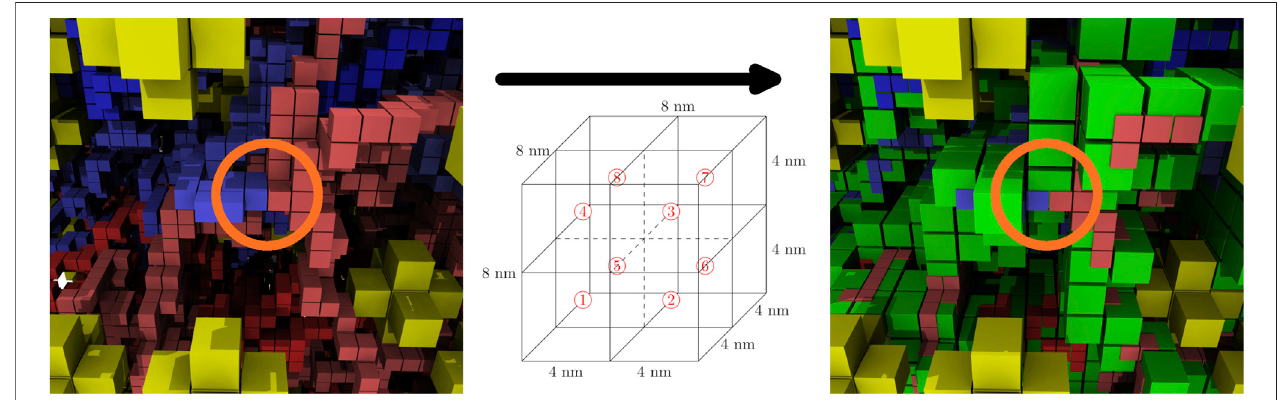
FIGURE 8 | Coarse-graining, before and after — The coarse graining procedure localizes up to eight effective monomers in the 4 nm chromosome con fi gurations (same color scheme as Figure 5 ) within the 8 nm chromosome lattice sites (green). Circled in orange there is an example of genomically-distant regions being localized within the same chromosome